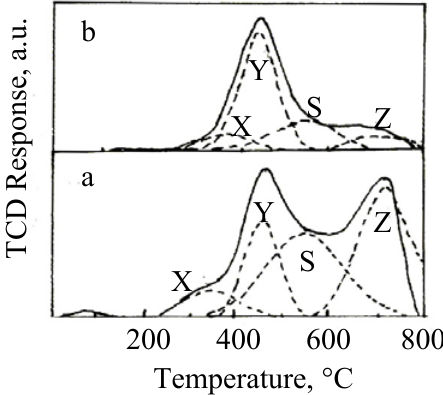
Figure 8 . The deconvolution results of the TPR profiles for ( a ) K(1.2) /AC(C). Solid and dotted lines are for experimental and fit ted curves,